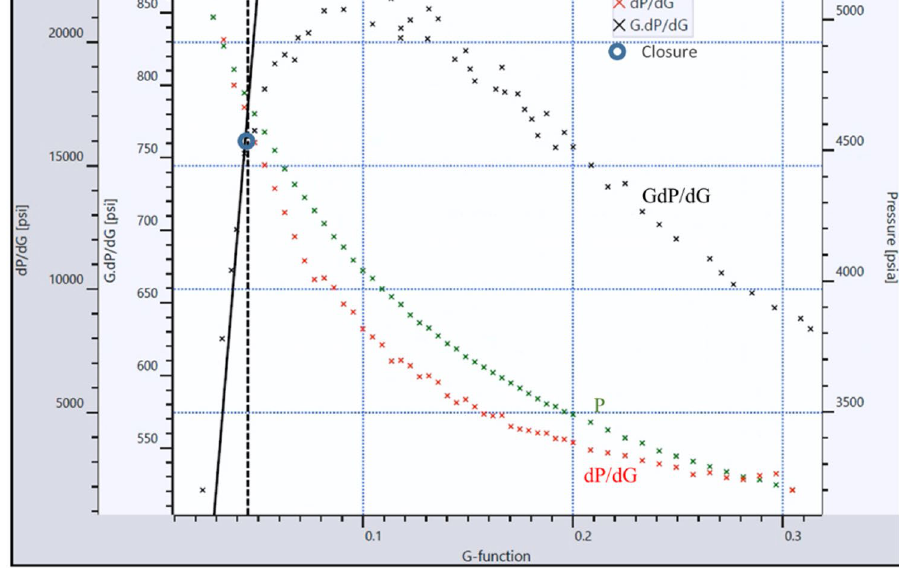
Fig. 21 Log–log diagnostic plot for the DFIT test simula- tion with no natural fracture. The log–log plot shows a fracture linear flow (½ slope) before the closer. After closure, it establishes bilinear flow with slope of ¼ on a plot of semilog derivative. Drawdown derivative is (∆ t d∆ P /d∆ t ), and semilog derivative is referring to the Bourdet